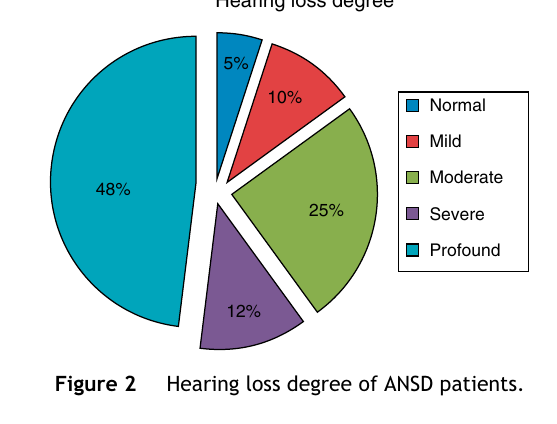
Etiological factors of ANSD patients.